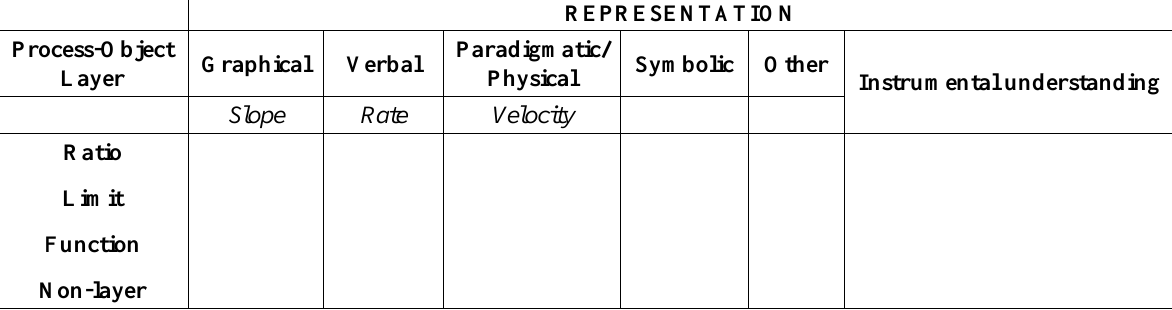
Figure 1: Theoretical framework ( Source: Adapted from Zandieh,